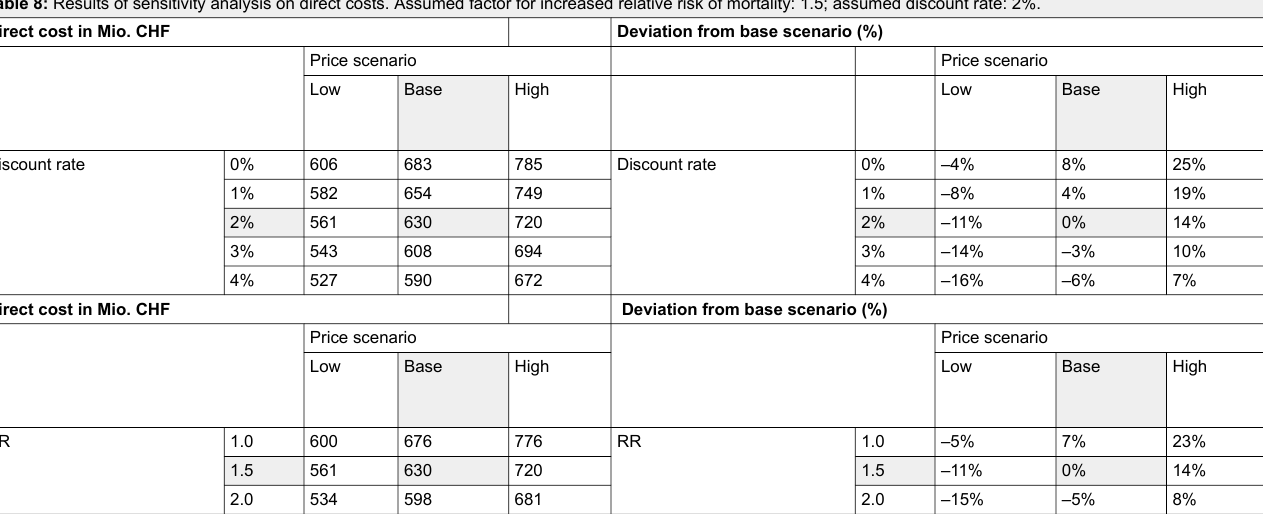
RR = factor for increased relative risk of